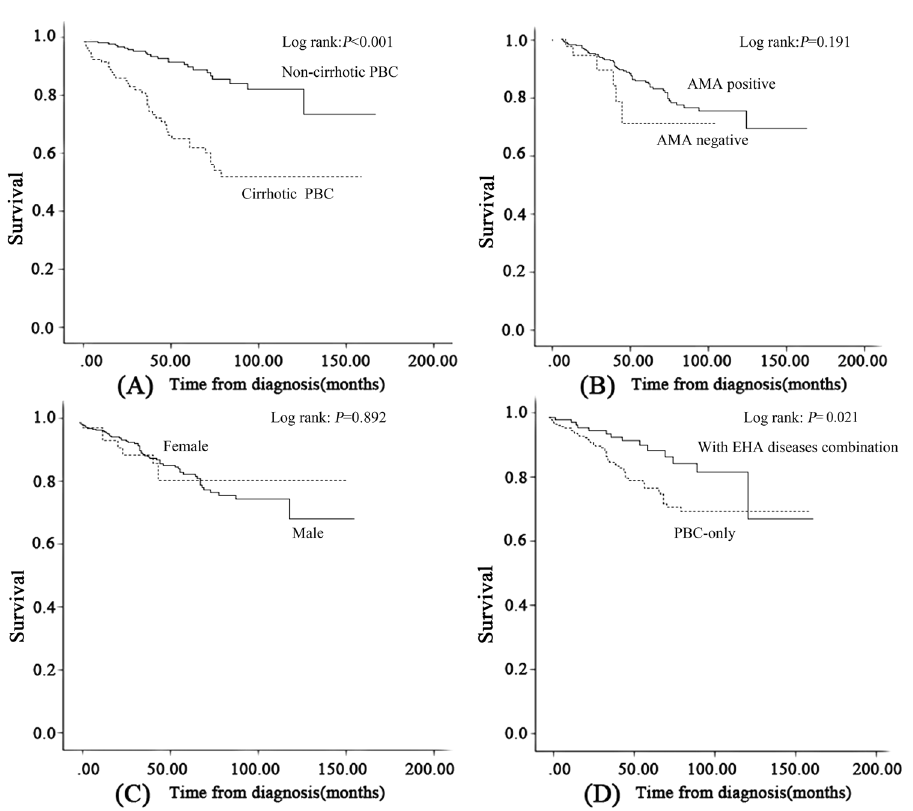
Figure 3. Kaplan–Meier plots for adverse outcome-free survival among patients with PBC stratified by stage, AMA status, gender and EHA disease combination. ( A ) PBC stage; ( B ) AMA status; ( C ) gender; and ( D ) EHA disease combination. A significant difference was observed between curves A and D ( p < 0.05). Abbreviations: PBC, primary biliary cholangitis; AMA, anti-mitochondrial antibody; EHA conditions, extrahepatic autoimmune